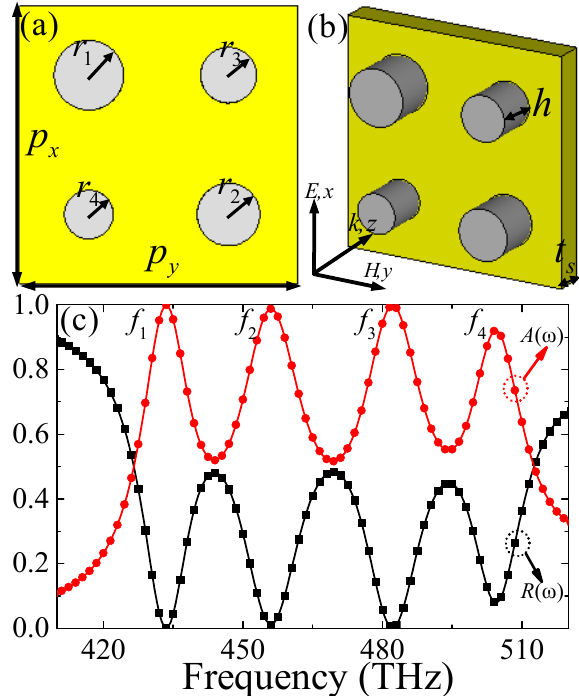
Figure 4 . ( a , b ) The unit-cell nanostructure of quad-band PPA and ( c ) the corresponding simulated reflectance ( R ( ω )) and absorbance ( A ( ω )) spectra.